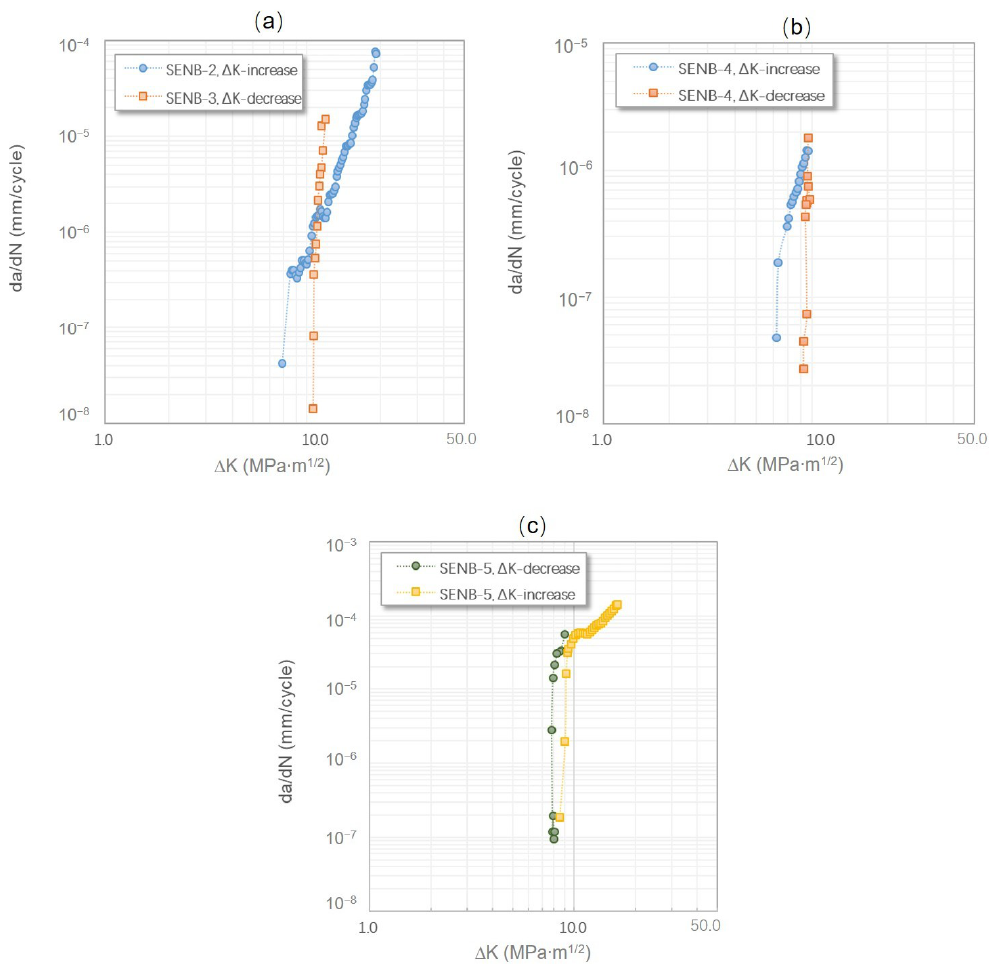
Figure 3. FCG curves of SENB specimens tested with different loading methods: ( a ) Specimens SENB-2 and SENB-3 were tested via solo load-increasing method and load-decreasing method, respectively, ( b ) Specimen SENB-4 was tested first by the load-increasing method and then by the load-decreasing method, and ( c ) Specimen SENB-5 was tested first by the load-decreasing method and then by